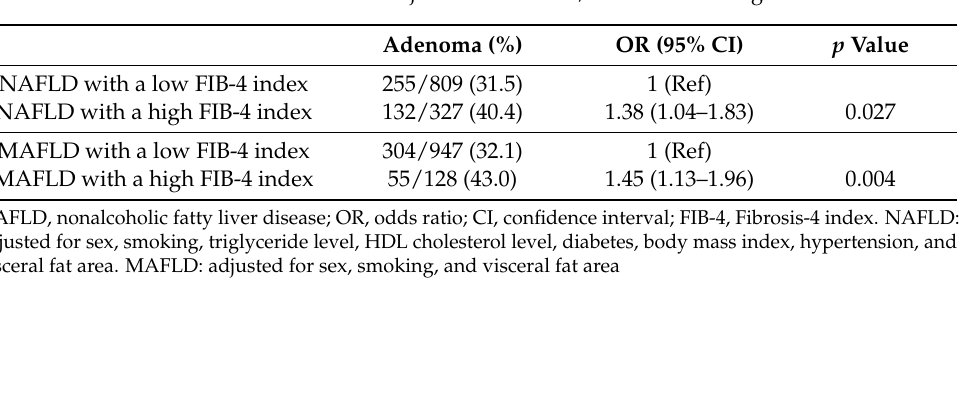
Table 5. The risk for colorectal adenoma in subjects with NAFLD/MAFLD according to advanced fibrosis. Adenoma (%)